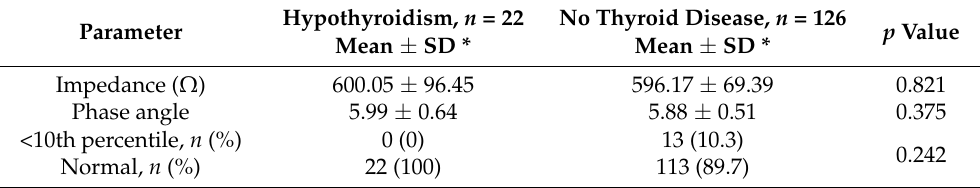
Table 5. Impedance Z and phase angle in the non-Hashimoto’s hypothyroidism group and in women without thyroid